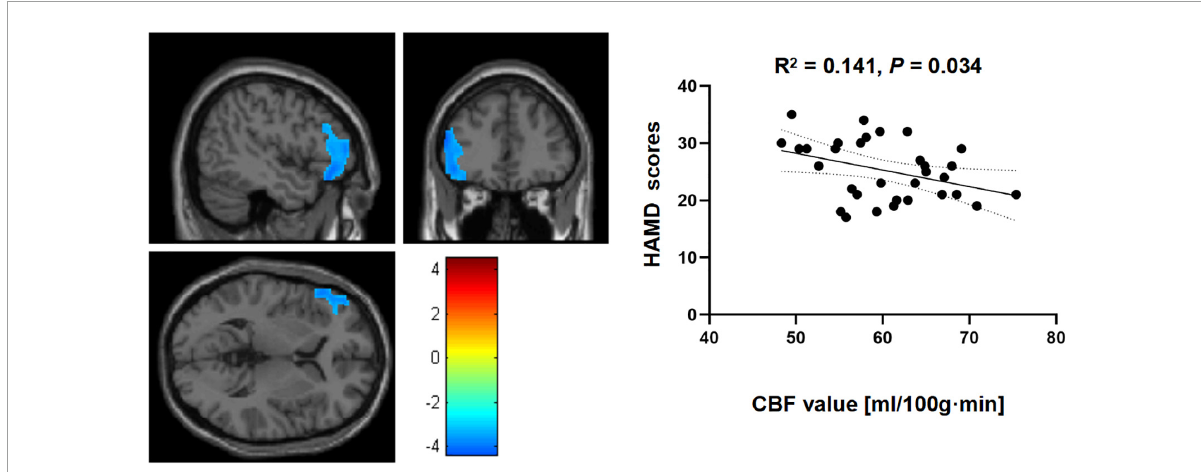
FIGURE2 Correlational analyses between cerebral blood flow (CBF) in the left triangular part of the inferior frontal gyrus (IFGtriang) and Hamilton depression scale (HAMD) scores for the two